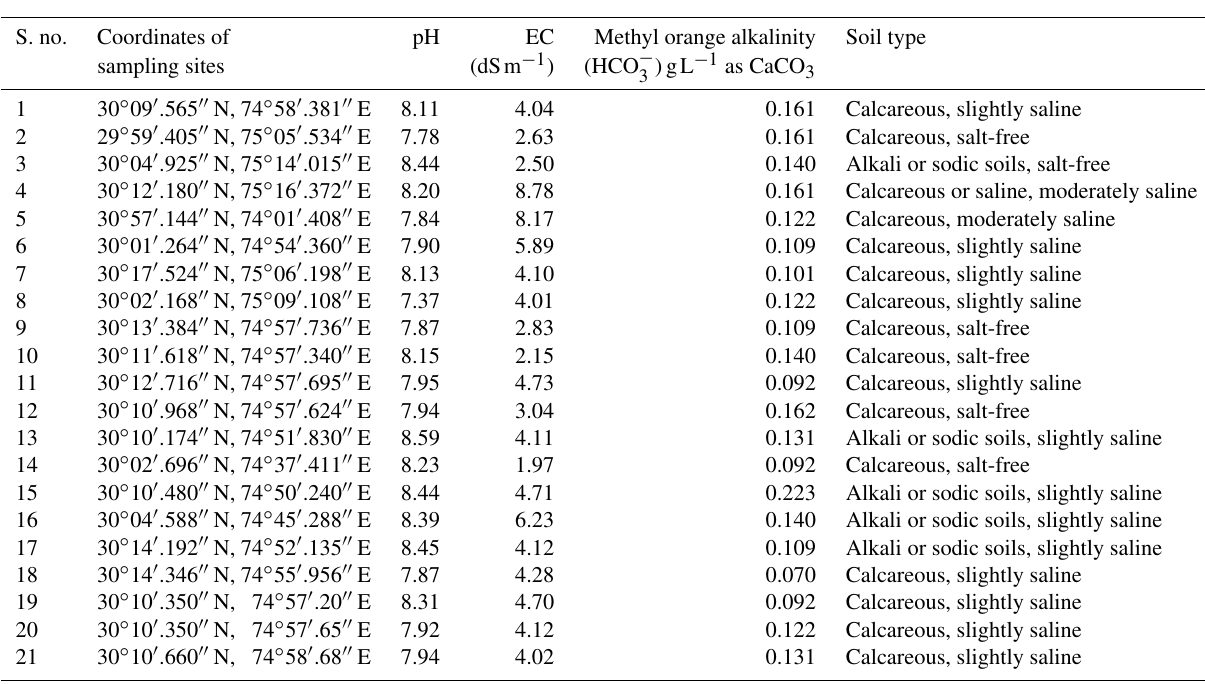
Table 5. Soil physico-chemical parameters. S.